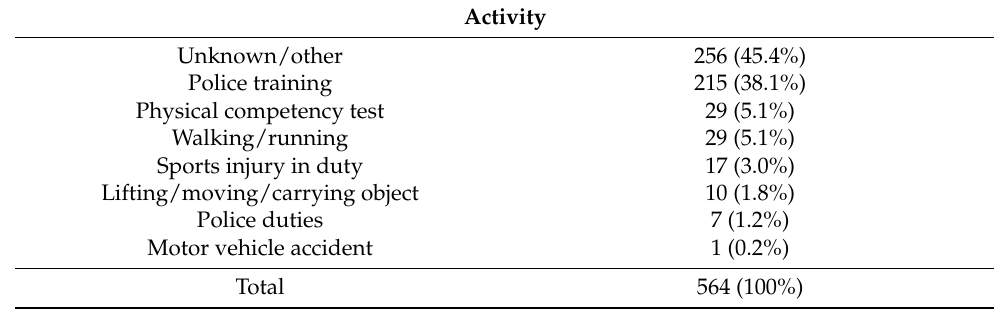
Table 6. ActivitywheninjuryoccurredintheNZPoliceForce.